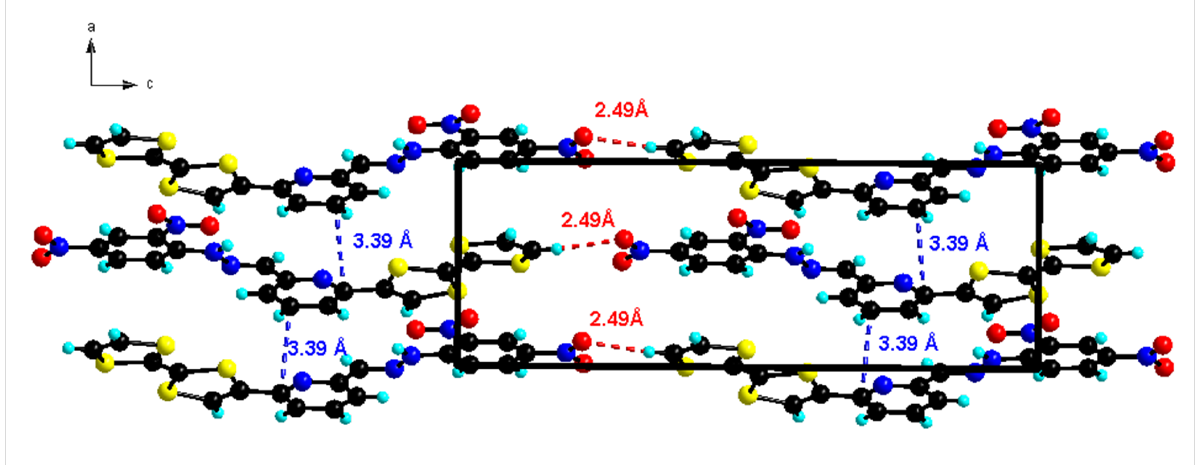
Figure 2: Partial crystal packing of ligand L1 with formation of head to tail dimers that stack along a -axis forming columns that are connected through hydrogen bonding along c -axis.